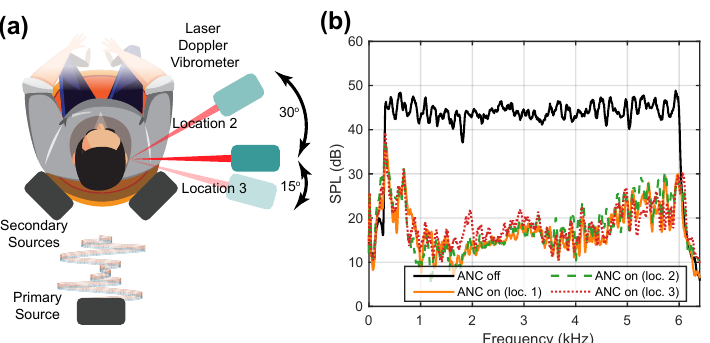
Figure 14. ( a ) Illustration of the alternative two locations for the LDV. ( b ) The sound pressure reduction levels observed by the HATS for the grey noise (300 Hz–6 kHz) at three